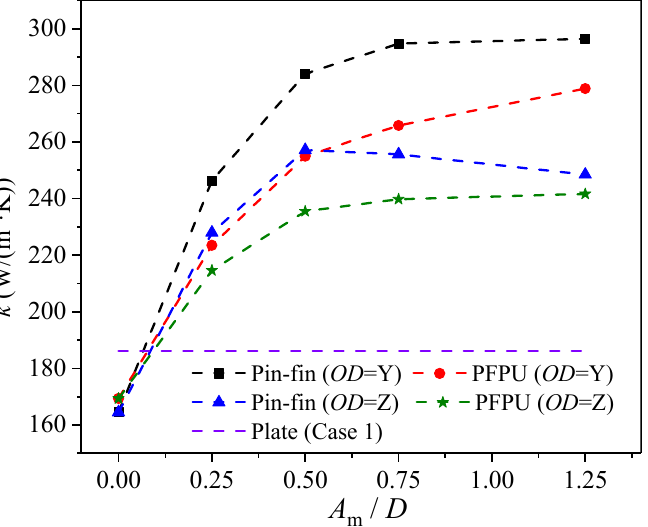
Figure 10. Variations of heat transfer coefficients of particles flow around different surface under different amplitudes.